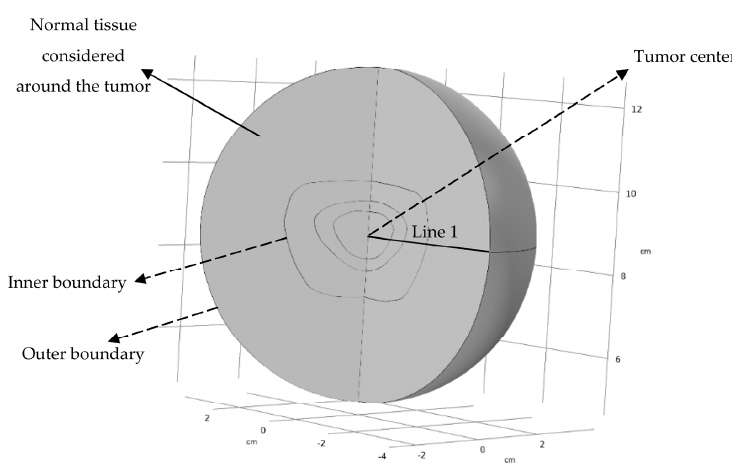
Figure 2. Computational geometry and boundaries. Results are drawn along line 1.